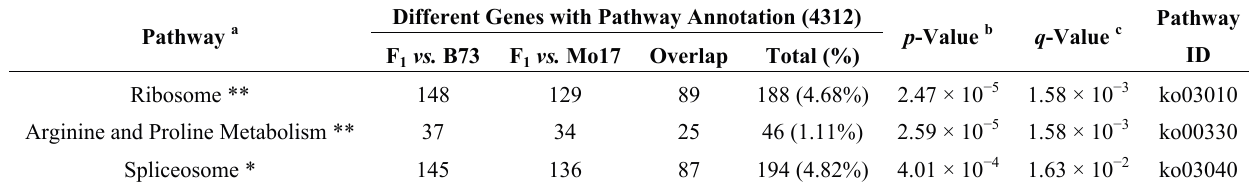
Table 5. Top 10 pathways differentially expressed genes enriched in between parental lines and their F 1